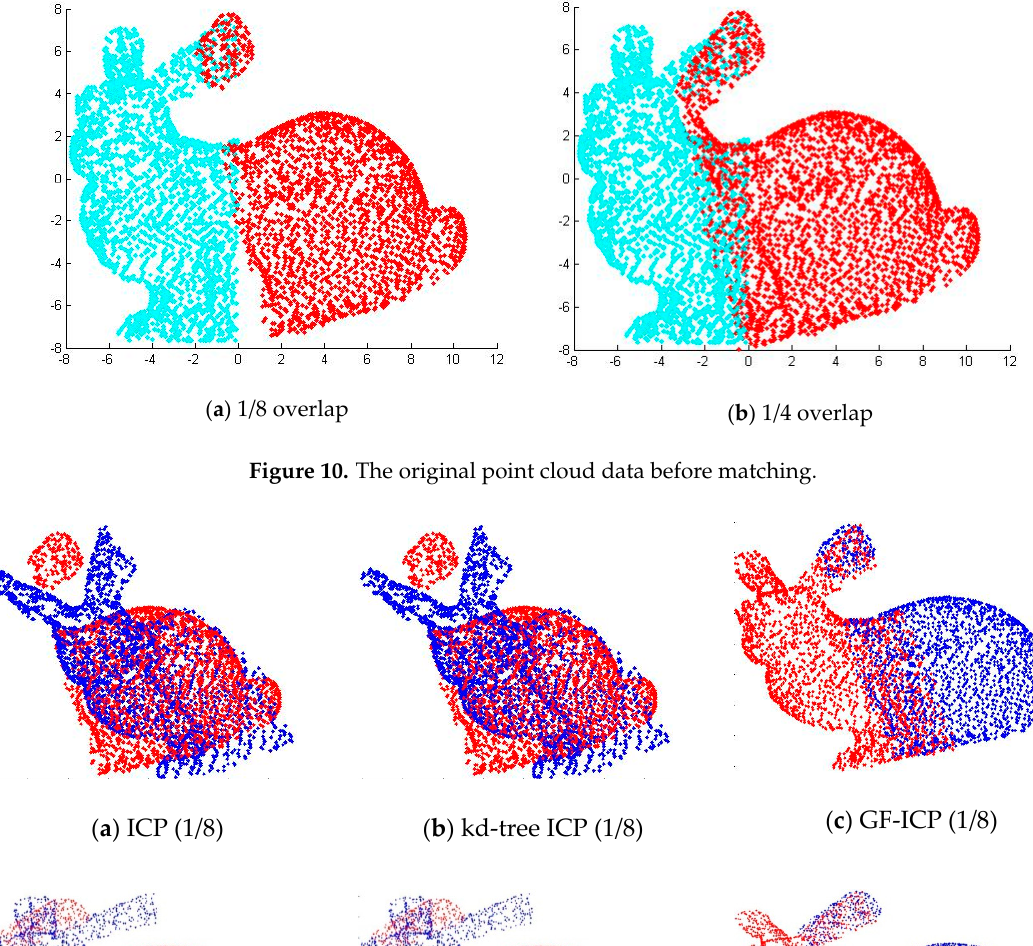
Figure 9. The overlap of point clouds.